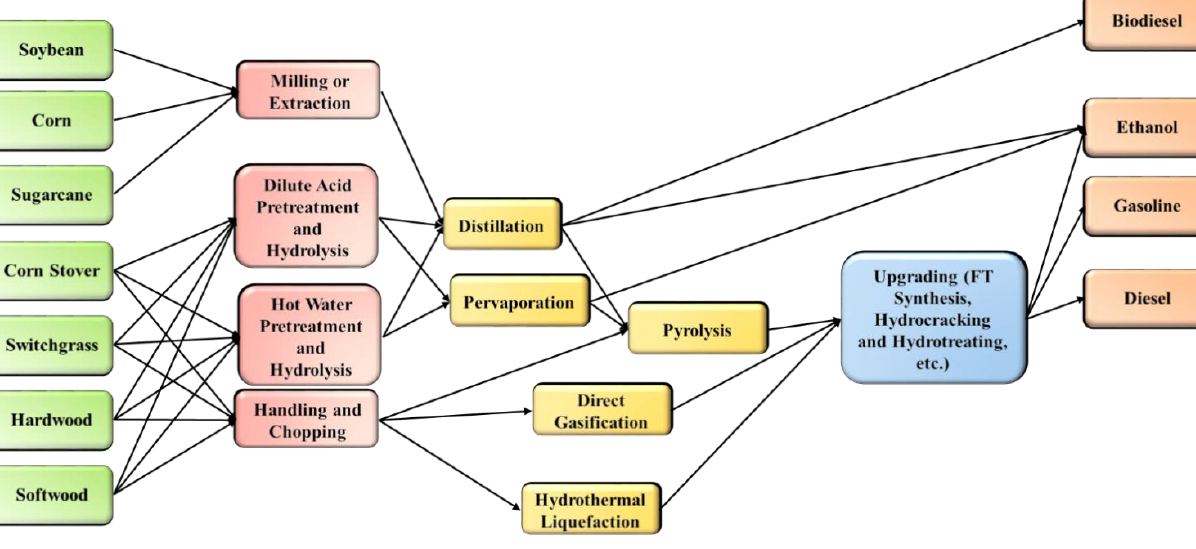
Figure 1. Sample subset of technologies in the model and their possible connections within a processing pathway.